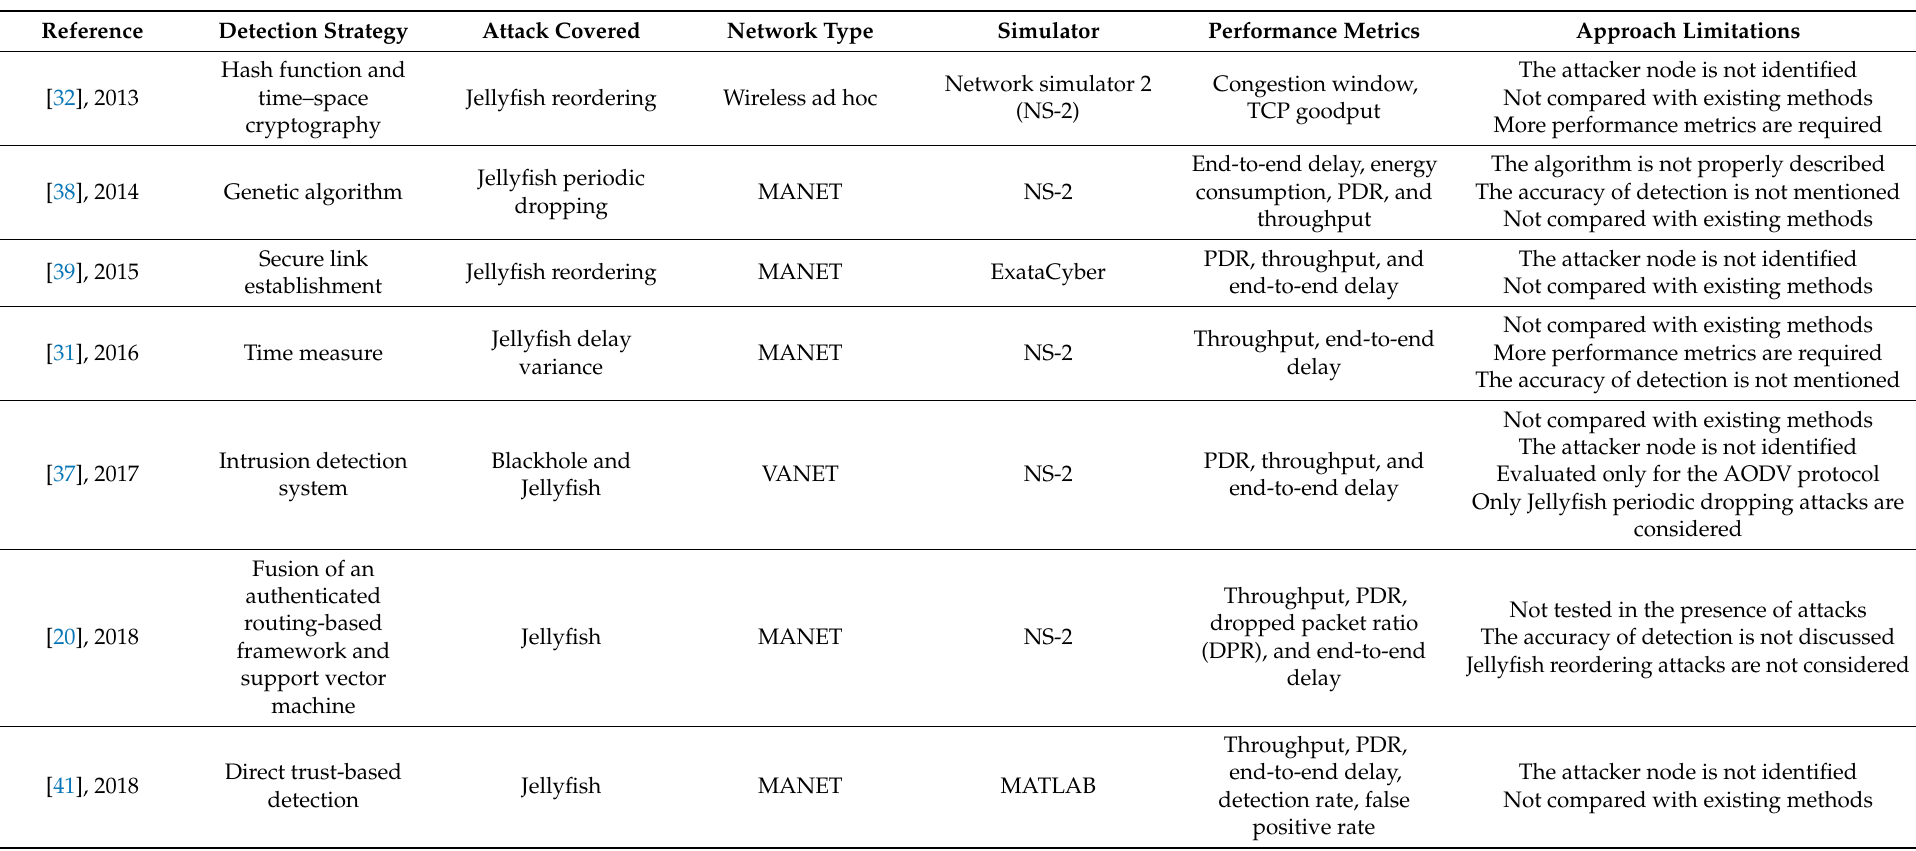
Table 2. Comparison between detection